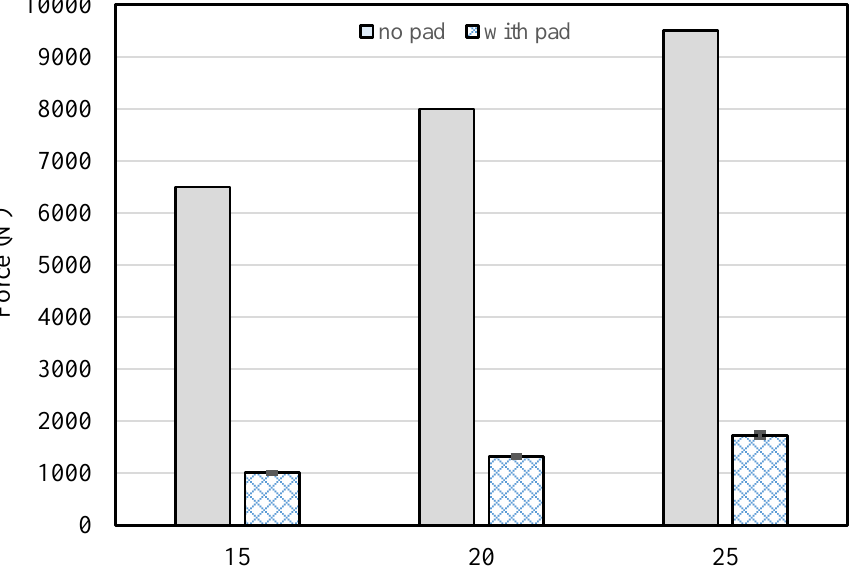
Figure 7. Impact-protection performance test without pad and with pad, in the cases of application of forces generated at heights of 15, 20, and 25 cm.